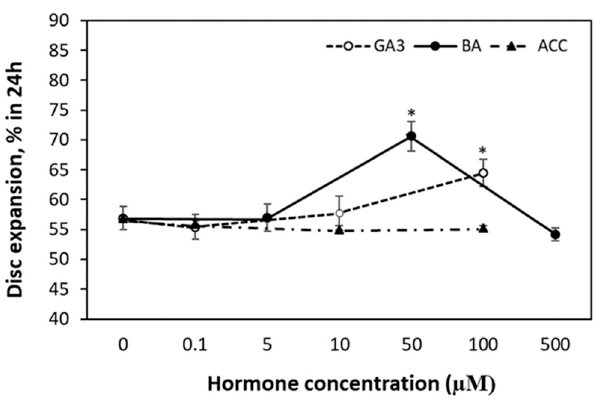
Figure 5. Area expansion of discs excised from the base of pepper leaves after incubation for 24 h on solutions of GA 3 : 0.1, 10 and 100 µM; BA: 5, 50 and 500 µM or ACC: 0.1, 10 and 50 µM. Bars are the mean ± SE of 10 replicates. Asterisks indicate significant ( p < 0.05) differences within hormone treatments.